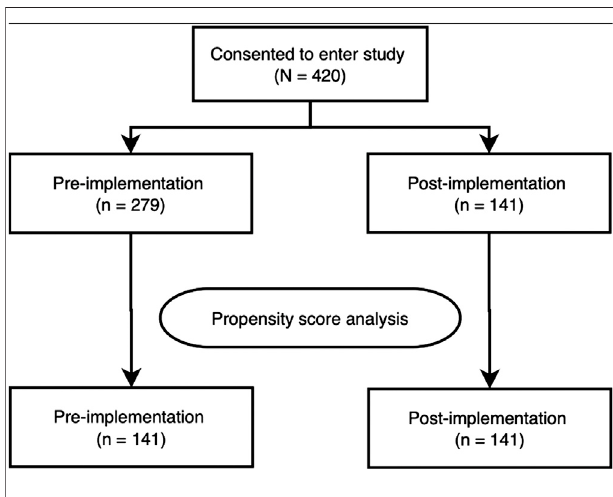
FIGURE 1 | Participant fl ow